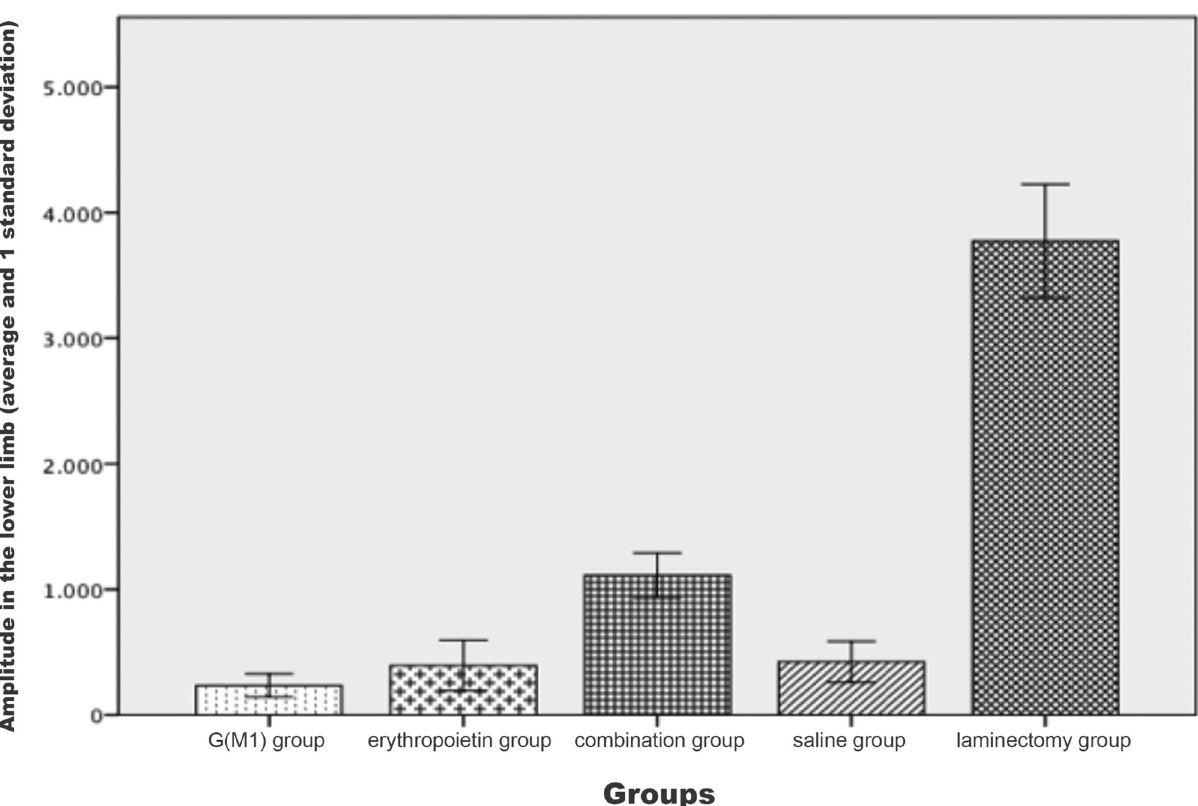
Figure 3 - Amplitude, as evaluated by motor evoked potential recording, in the lower limbs of Wistar rats subjected to experimental spinal cord contusion lesioning and of control rats not undergoing experimental lesioning.